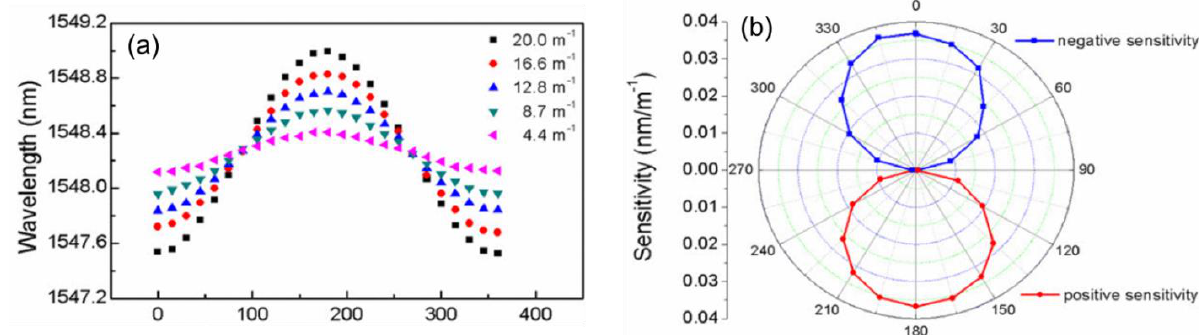
Figure 8. ( a ) Resonant wavelength of one peak in the reflection spectrum of TC-FM FBG as a function of the bend direction angle under different bend curvatures. ( b ) Bend sensitivities of the TC-FM FBG in different bend directions. Adapted with permission from Ref. [41] © IEEE.